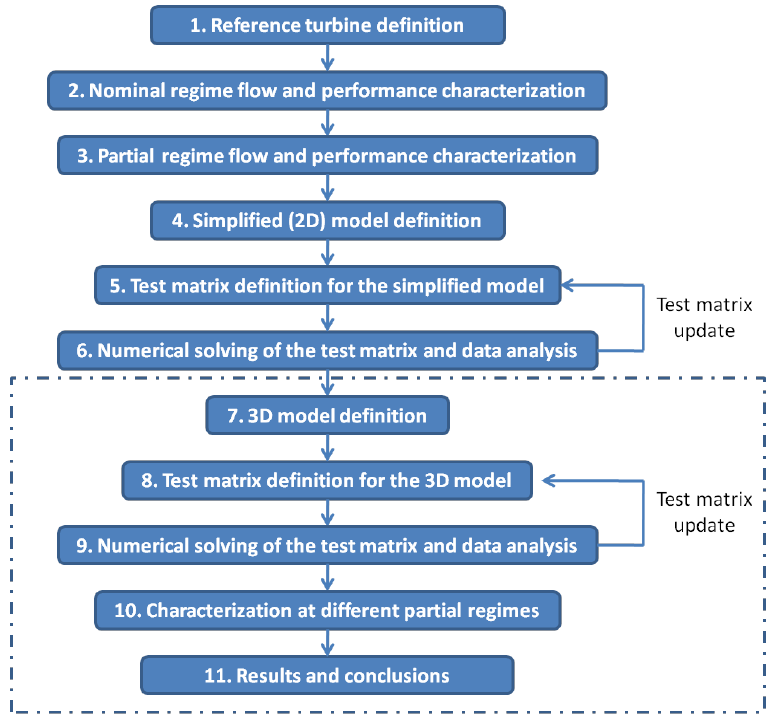
Figure 1. Study methodology for injection method characterization.